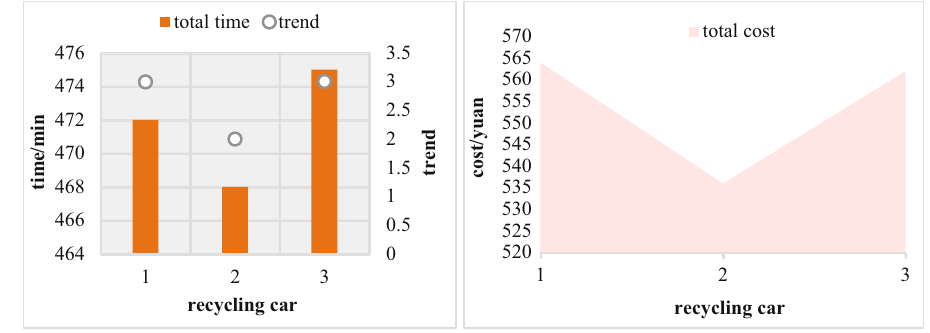
Figure 8: Total time spent and total cost of car recovery: ( a ) total time spent and ( d ) total